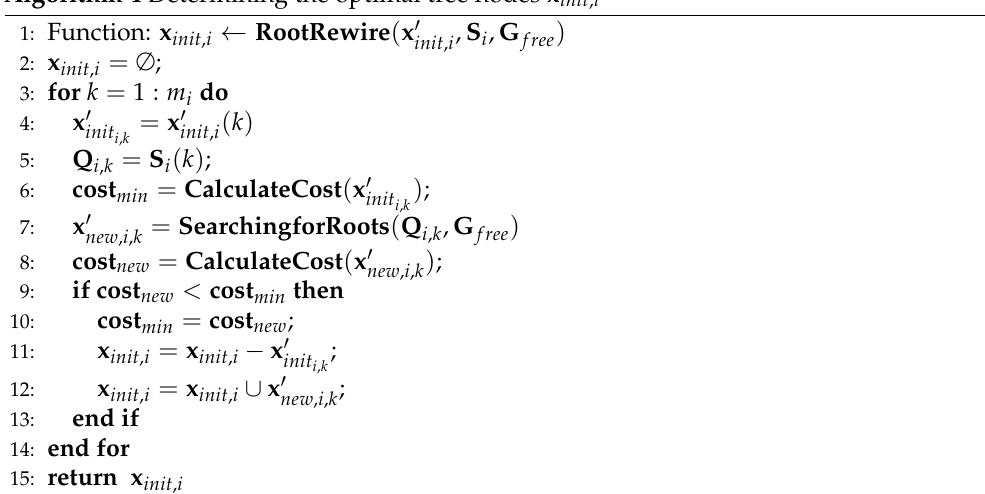
Algorithm 4 Determining the optimal tree nodes x init ,